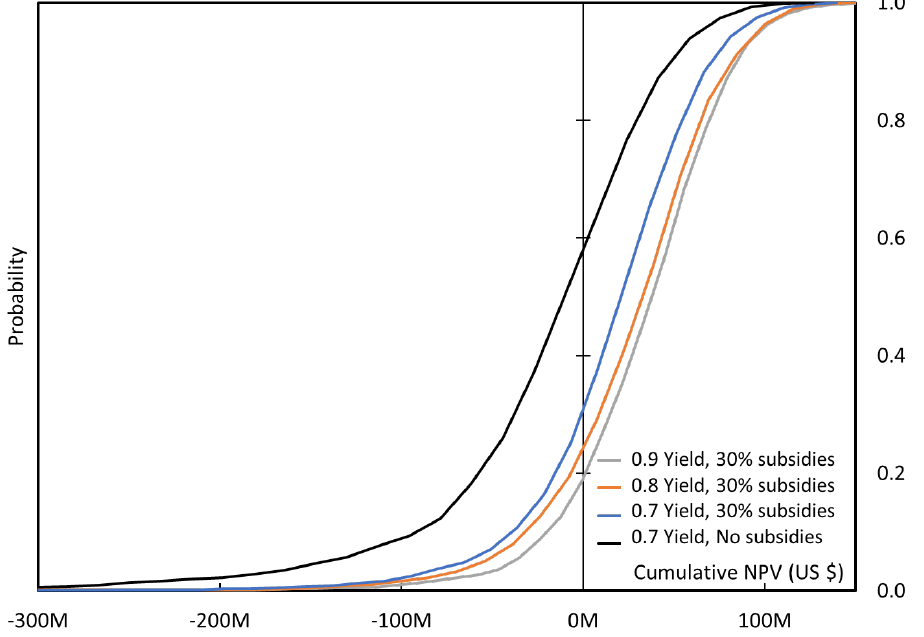
Figure 17. Probability vs. cumulated NPV in 10 years of production for a 50,000 tons/year plant with and without 30% subsidies.